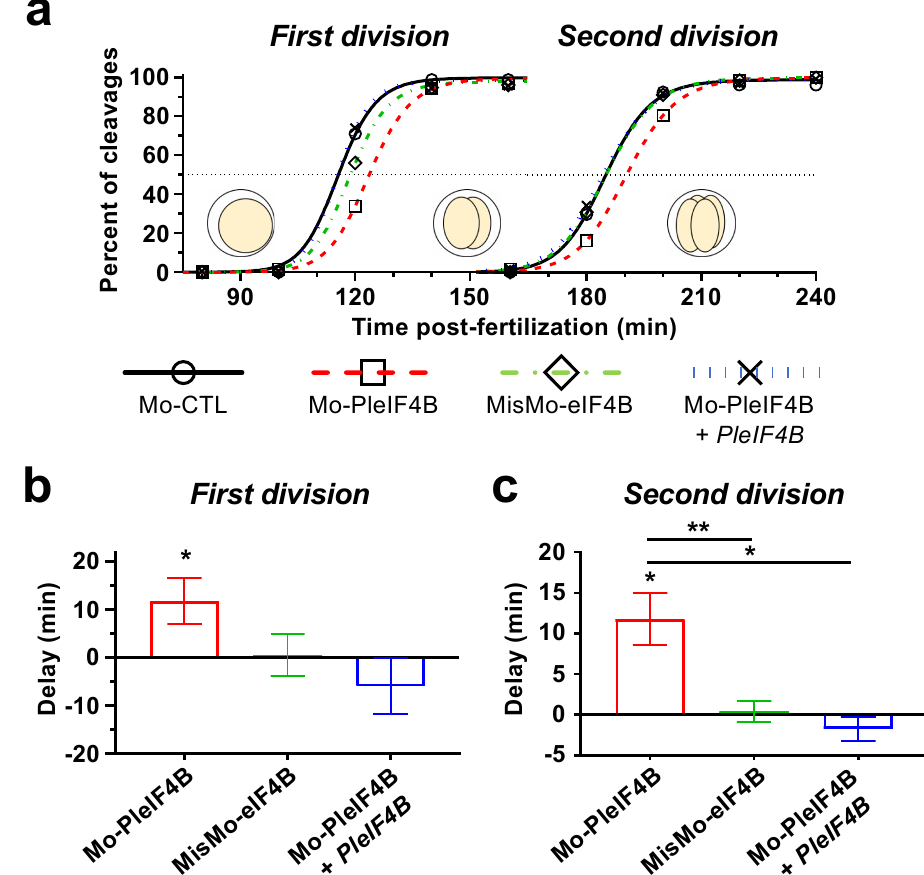
Figure 3. Microinjection of a morpholino directed against P. lividus eIF4B mRNA delays the onset of the two first cell divisions. ( a ) Graph showing the cell division kinetics observed in a single representative experiment in which we compare the development of embryos injected with different MOs in the presence or absence of mRNA. The first and second cell divisions are delayed upon injection of a morpholino directed against P. lividus eIF4B mRNA (Mo-PleIF4B). As controls, we injected a scrambled morpholino (Mo-CTL), a mismatched morpholino (MisMo-eIF4B), and a rescue PleIF4B mRNA, which Mo-PleIF4B does not target. All MOs were injected at 333 µ M. Mo-CTL, Mo-PleIF4B, and MisMo-eIF4B were co-injected with 100 ng/ µ L of Firefly luciferase or PleIF4B mRNA. This figure is representative of four independent experiments performed with gametes of four different females. ( b , c ) Graphs representing the time delay (min) observed at the first ( b ) or second cleavage ( c ) with respect to the values obtained in the Mo-CTL (333 µ M) injected embryos used as a reference to calculate delays. Time values correspond to 50% cleavage completion, and positive delays indicate that the embryos develop at a slower pace than the reference population. For each condition, 100 eggs were microinjected, fertilized and monitored throughout early development. Error bars represent the SEM of four independent experiments. ( t -test: * p -value < 0.05; ** p -value < 0.01). We examined whether PleIF4B overexpression could elicit the opposite effect. For this, we injected PleIF4B into unfertilized eggs and monitored the dose ‐ dependent effect concentration of 67.5 or 125 ng/ µ L, injection of PleIF4B mRNA significantly accelerates the rhythm of the two first mitotic cleavages with respect to controls. In contrast, injection of higher amounts of PleIF4B mRNA results in division rates comparable to those observed in control embryos, suggesting that an optimal level of eIF4B is required to accelerate development.